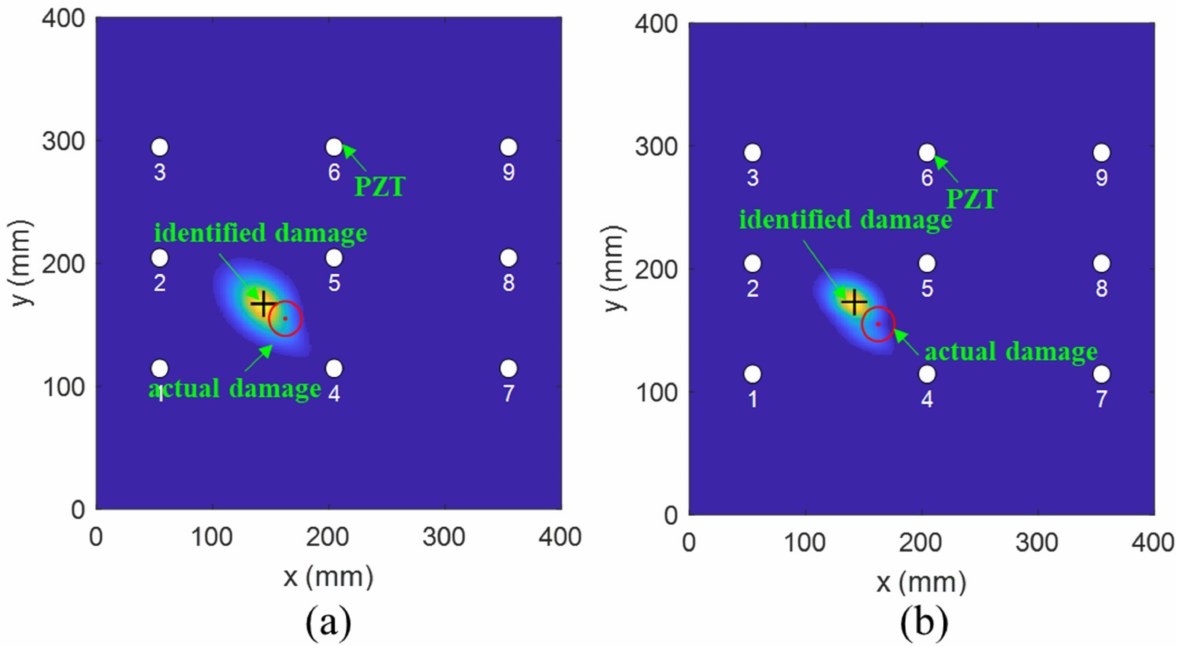
Figure 16. The imaging results of one virtual damage at location (162 mm, 155 mm) obtained by ( a ) the fused PDI method and ( b ) the conventional PDI